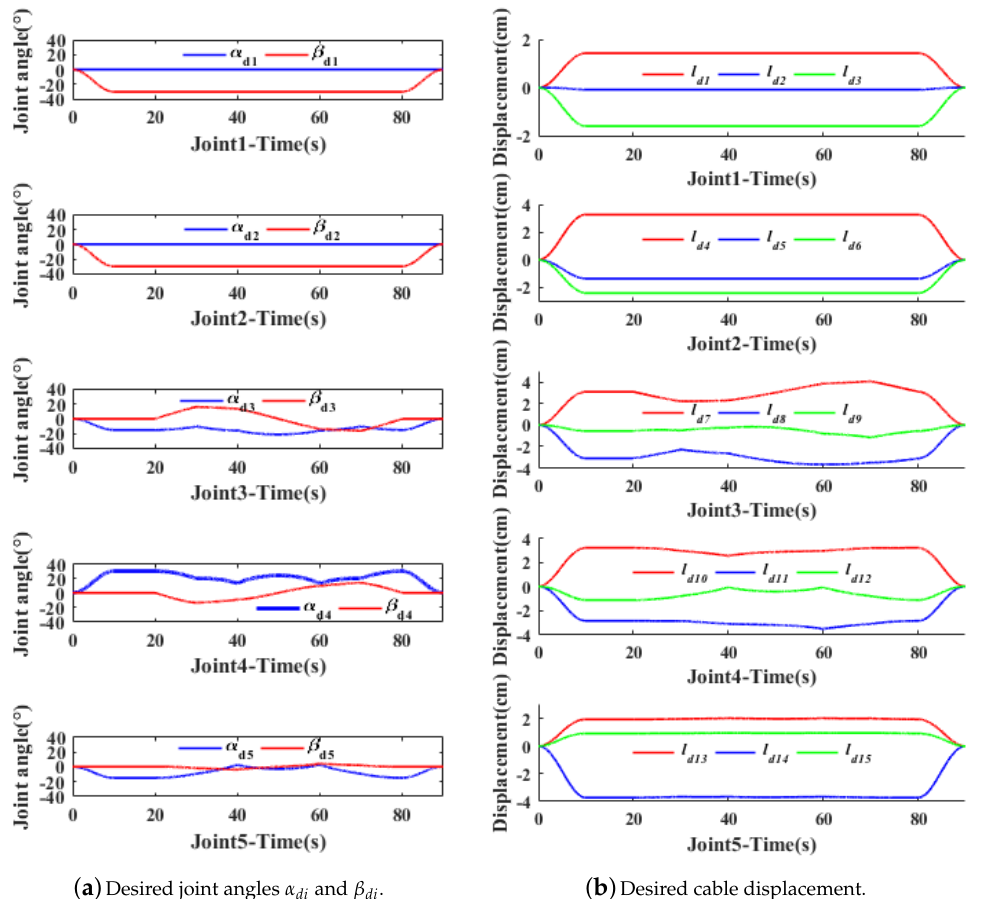
Figure 11. Desired joint angles and cable displacement of SET1 in the underwater